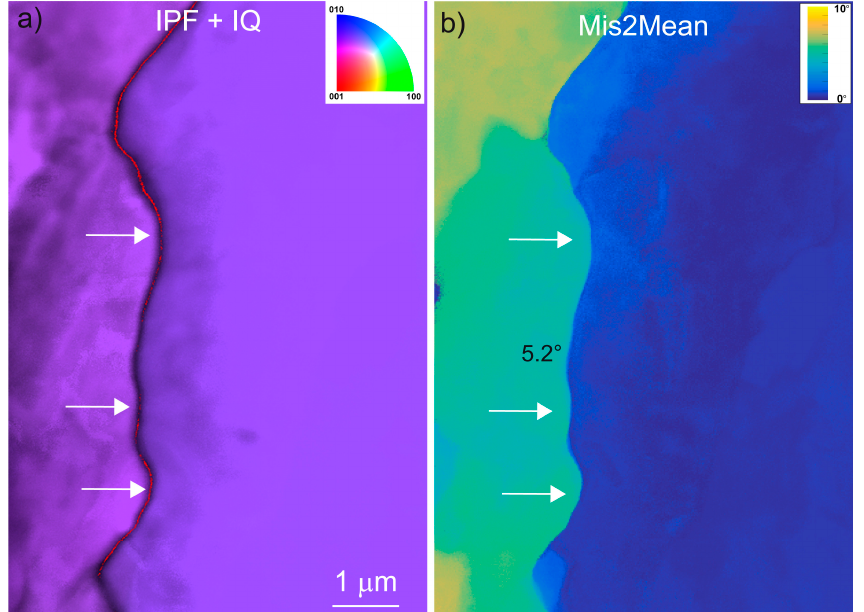
Figure 3. M642 SGB (indicated by white arrows). ( a ) IPF corresponding to the direction perpendicular to the plane of view superimposed with the IQ (Equation (1)); color code inserted ( Pnma ). White arrows point to a SGB (highlighted by a red line) with a misorientation of 5.2°. ( b ) Mis2Mean map corresponding to ( a ), up to 10°.